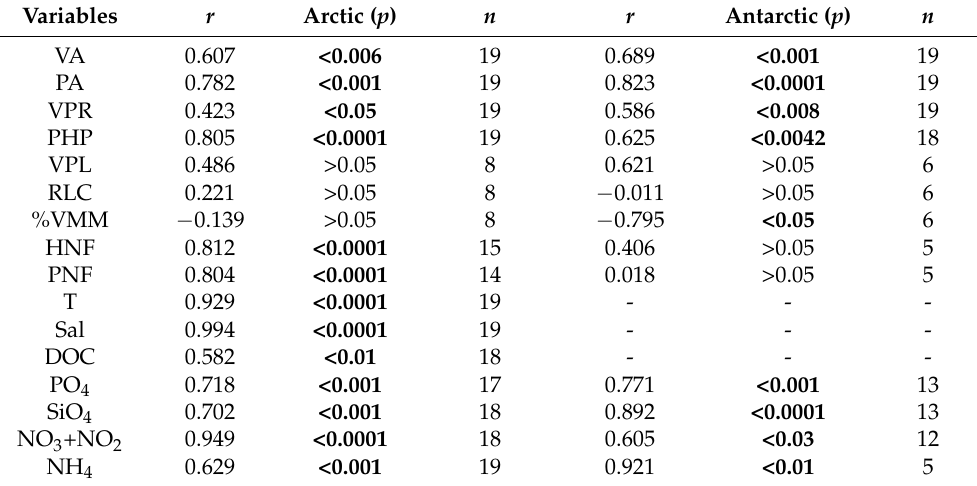
Table 3. Pearson correlation analyses for each variable between the SML and the SSW for Arctic and Antarctic seawaters. Values in bold are significant. Acronyms of variables are shown in Tables 1 and 2. -: no data.